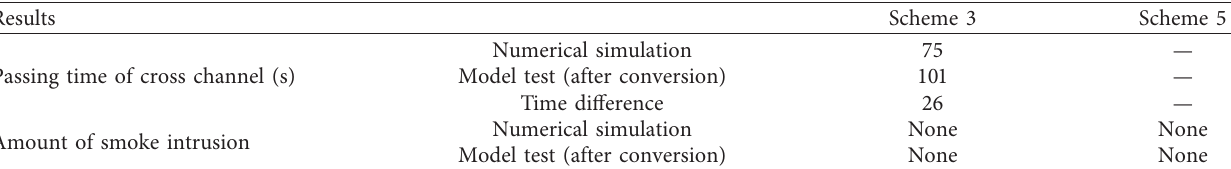
Table 3: Comparison of time it takes for the smoke to spread to the cross channel and the amount of smoke intrusion of Scheme 3 and Scheme 5.